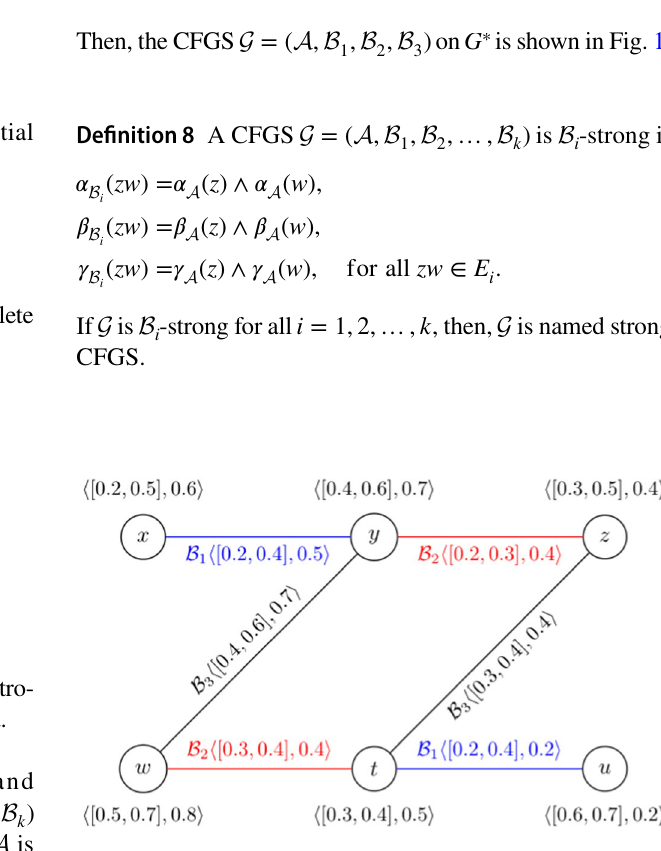
Fig. 1 The CFGS G = ( A , B 1 , B 2 , B 3